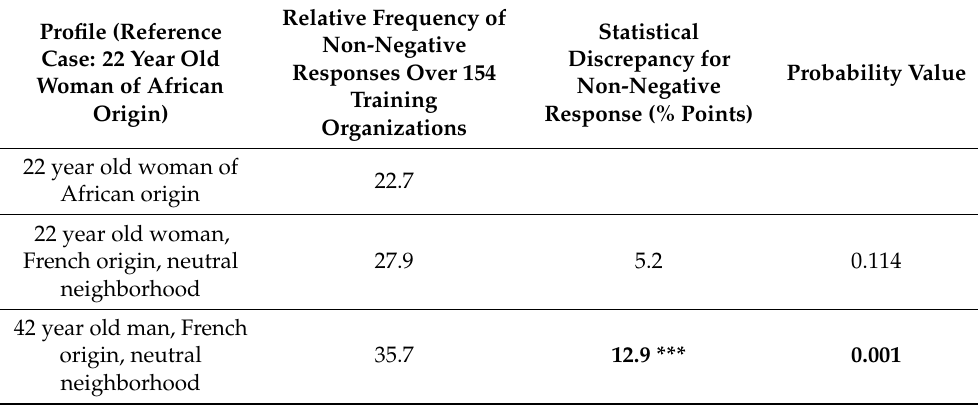
Table 1. Differences in the non-negative response rate emanating from the same vocational training organizations (estimated discrimination parameters) (reference profile: 22 year old woman, African